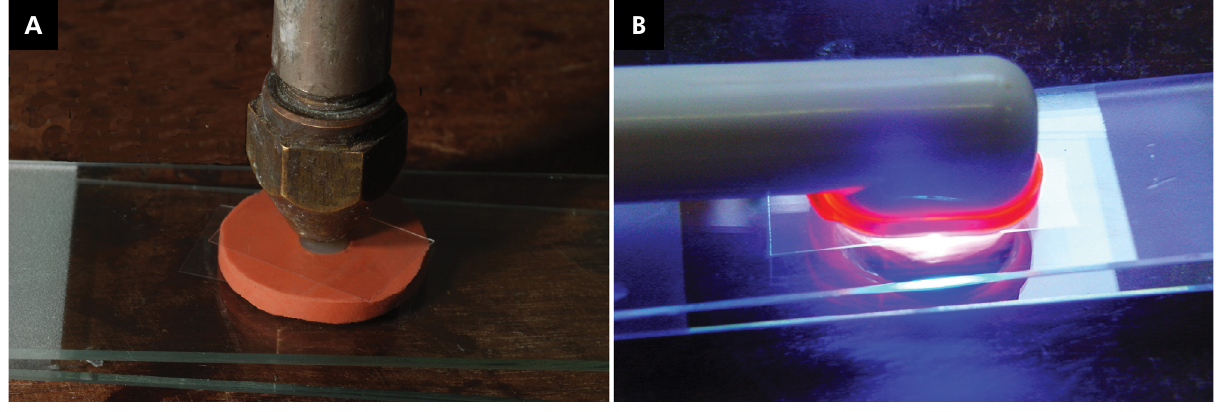
Figure 3. Rubber mold, filled with the resin cement (a) and Photoactivation (b).